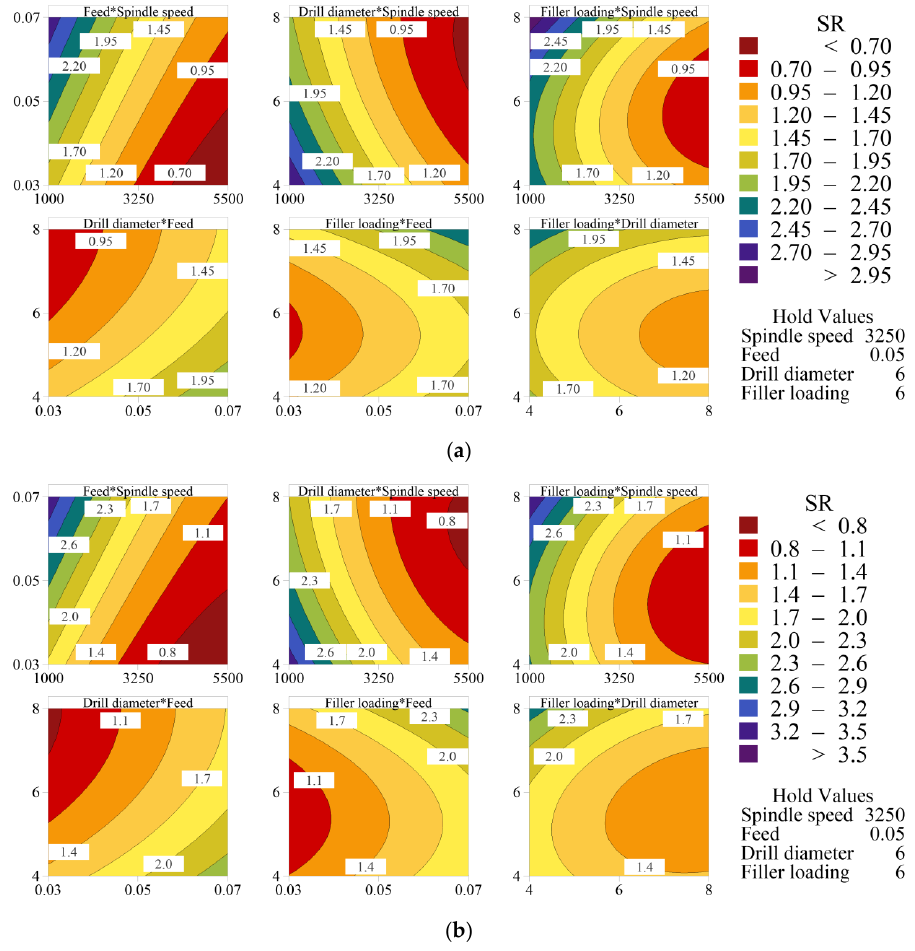
Figure 17. Surface roughness contour plot of ( a ) MoS 2 -loaded CEC and ( b ) h-BN-loaded CEC. Table 20. Experimental and RSM-predicted results of validation